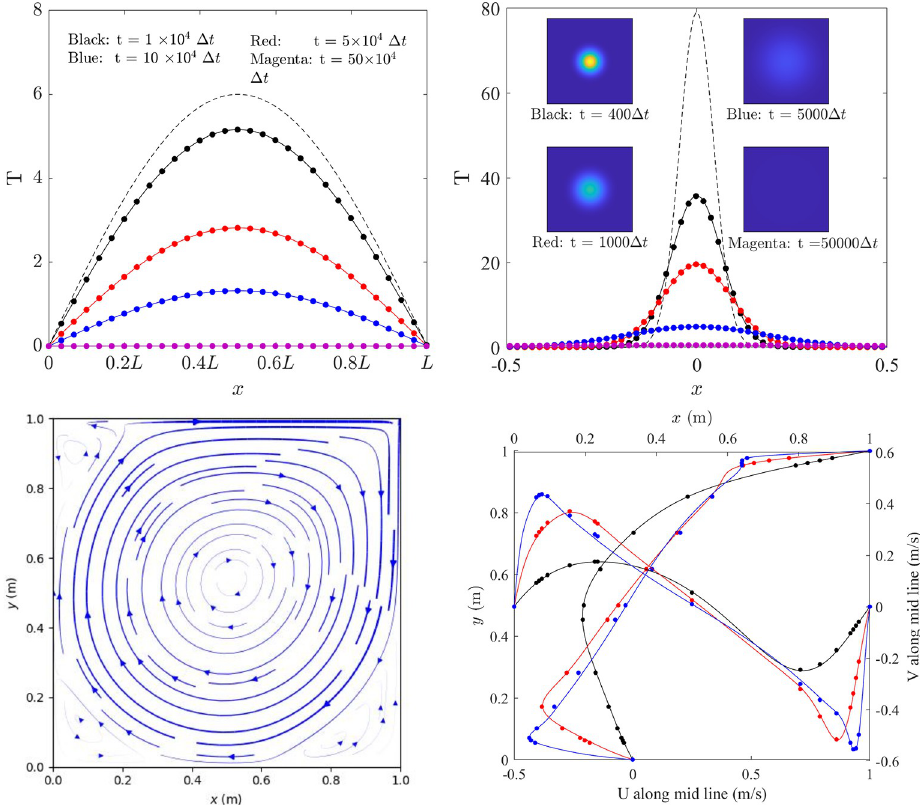
Fig 3. Boundary-value problems and solutions for the examined numerical models. (a) Solution to the 1D heat equation with Dirichlet boundary conditions (the dashed line = initial condition; solid lines = analytical solutions; dots = numerical solutions). (b) Solution along the midline to the 2D heat equation with Dirichlet boundary conditions (dashed line = initial condition; solid lines = analytical solutions, dots = numerical solutions; insets = temperature contours). (c) Calculated streamline of cavity flow with Re = 5000 (thickness indicates velocity magnitude). (d) Velocity along the midlines ( U vs. y and V vs. x ; solid lines = numerical solution from this study, dots = numerical solution from Ghia et al . [21]; black Re = 100; red Re = 1000; blue Re = 5000).